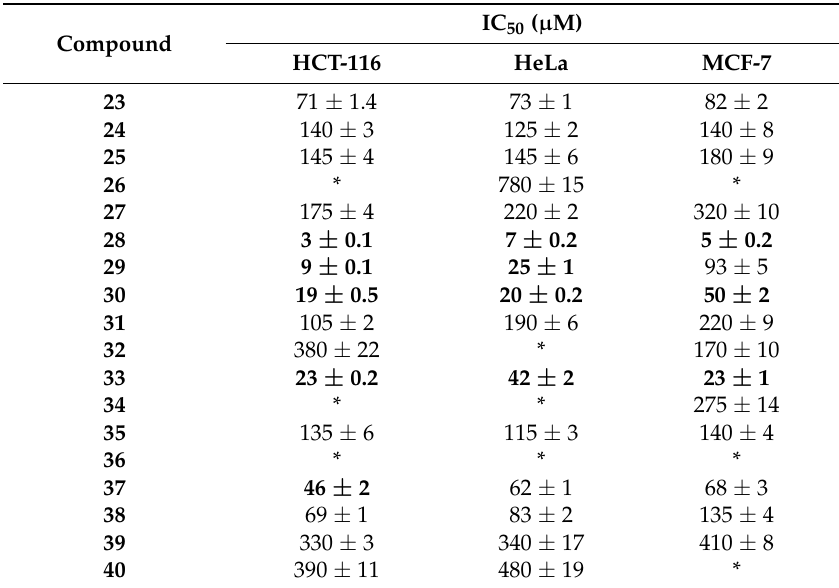
Table 3. IC 50 values for compounds 23 – 40 assessed by the MTT tests a